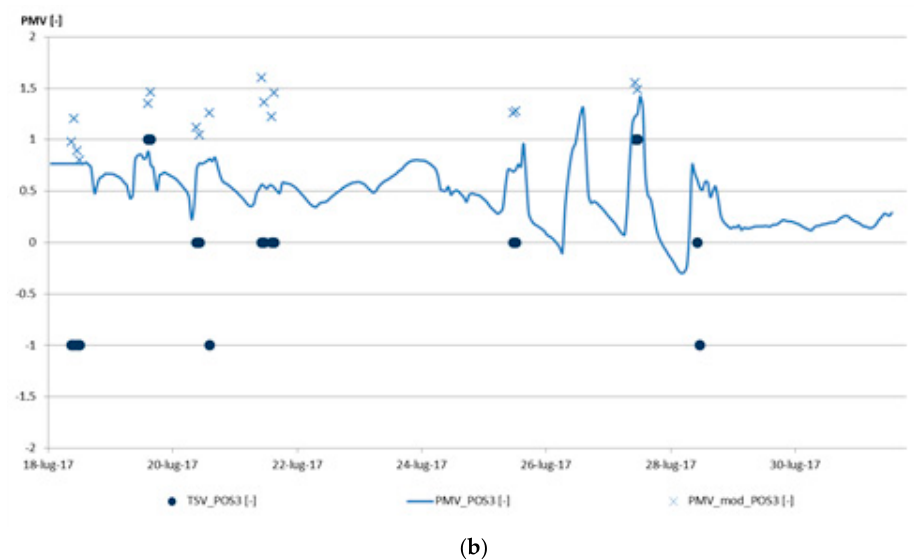
Figure 5. Modified PMV calculated as a function of metabolic rate: ( a ) Pos.1; ( b ) Pos.